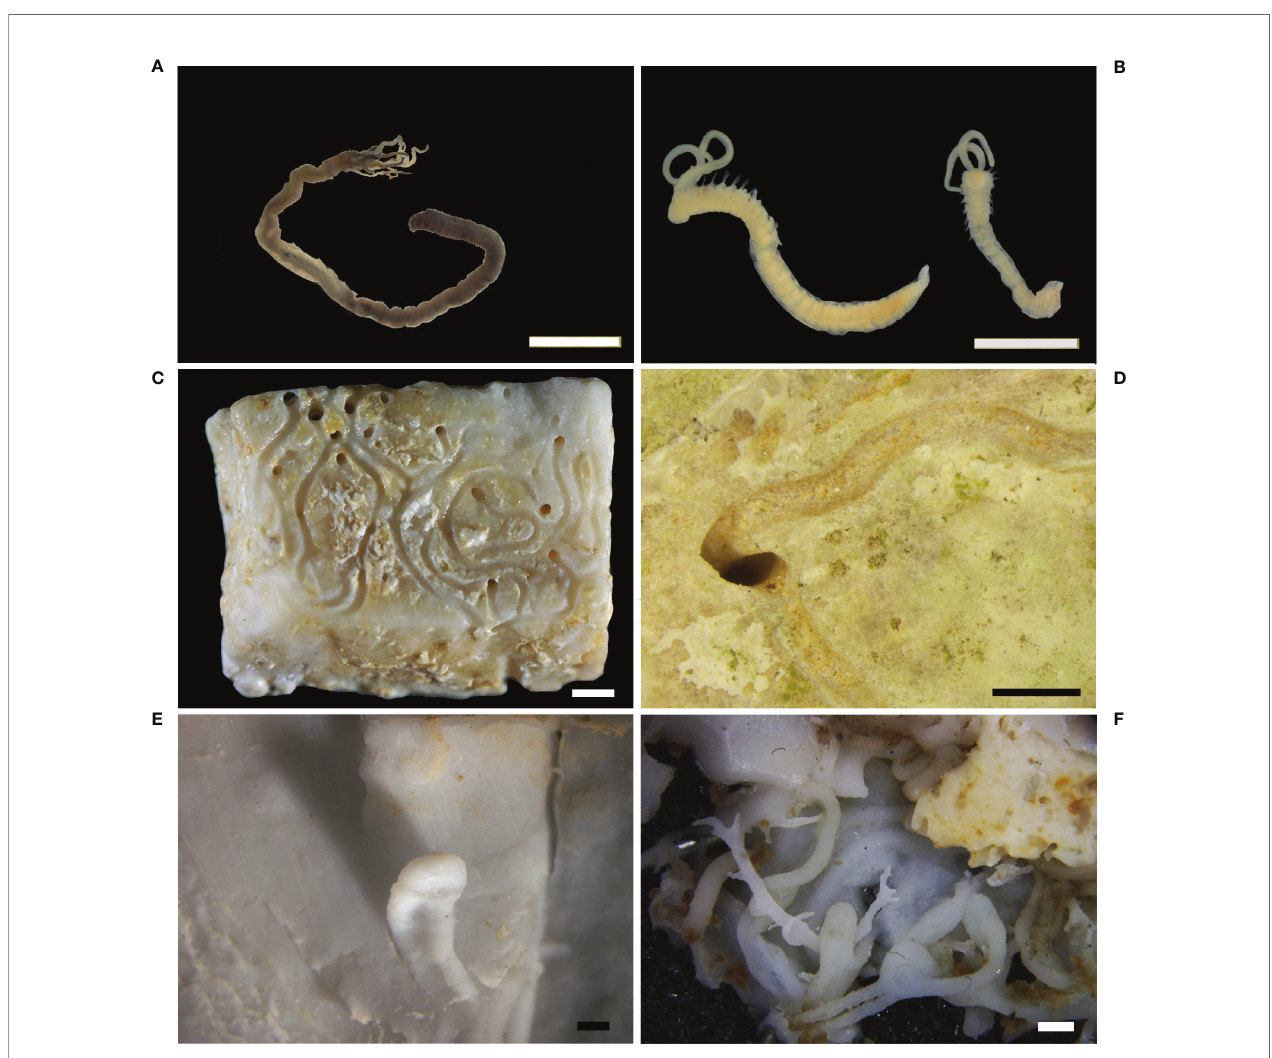
FIGURE 8 | Polychaetes. (A) The cirratulid Dodecaceria concharum from Portus Julius , Baiae; (B) the spionids Polydora ciliata : specimens from the tesserae of the Roman mosaic fl oor of Baiae; (C) circular holes and a 8-shaped hole associated to sinuous and semi-spiraled furrows on a limestone mosaic tessera, Baiae; (D) elliptic hole associated to sinuous furrows on the surface of a limestone tessera, Baiae; (E) silicone cast of Caulostrepsis taeniola showing the limbs interconnected by a distinct vane; (F) silicone cast of Meandropolydora decipiens showing irregularly disposed cylindrical galleries, also bent into lobes enlarged as pouches. Scale bars: 1